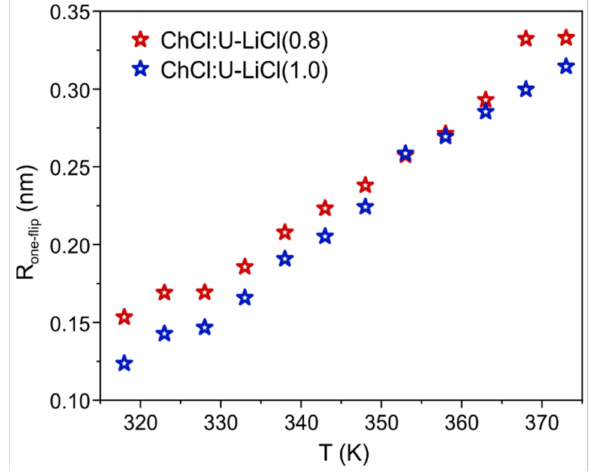
Figure 5. Average single-jump distance for a lithium ion in the two Li-doped systems (0.8 mol/kg = red, and 1.0 mol/kg = blue), as a function of temperature.